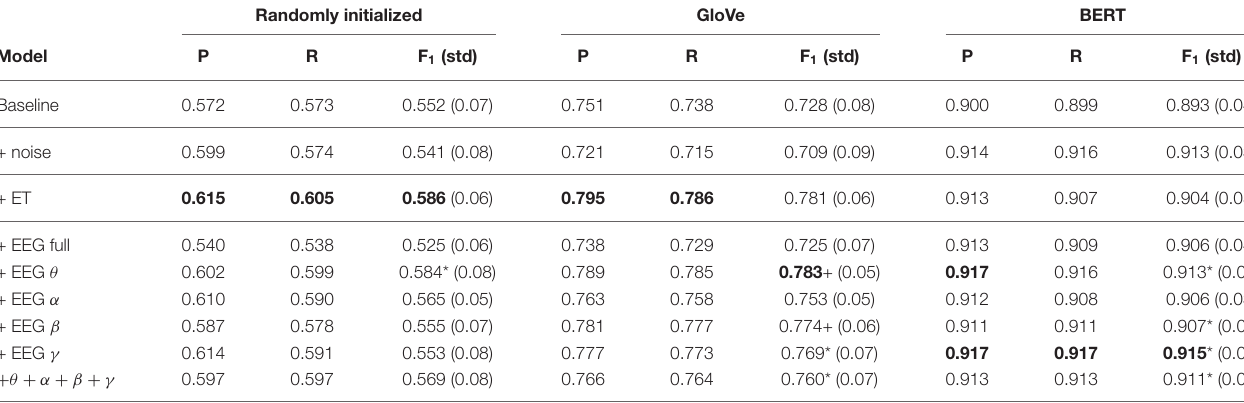
TABLE 4 | Binary sentiment analysis results of the multi-modal model using the recurrent EEG decoding component . Randomly initialized GloVe BERT